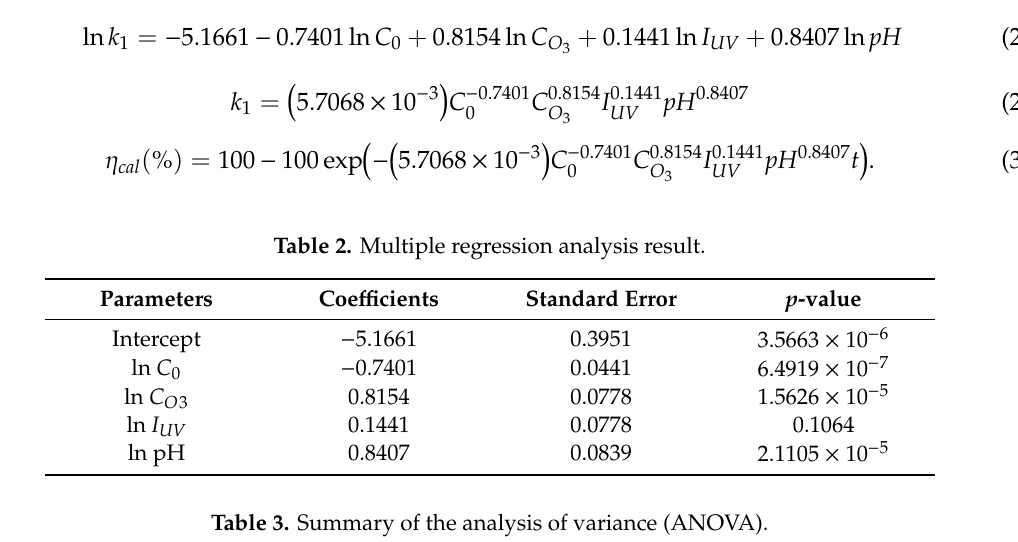
Table 3. Summary of the analysis of variance (ANOVA).